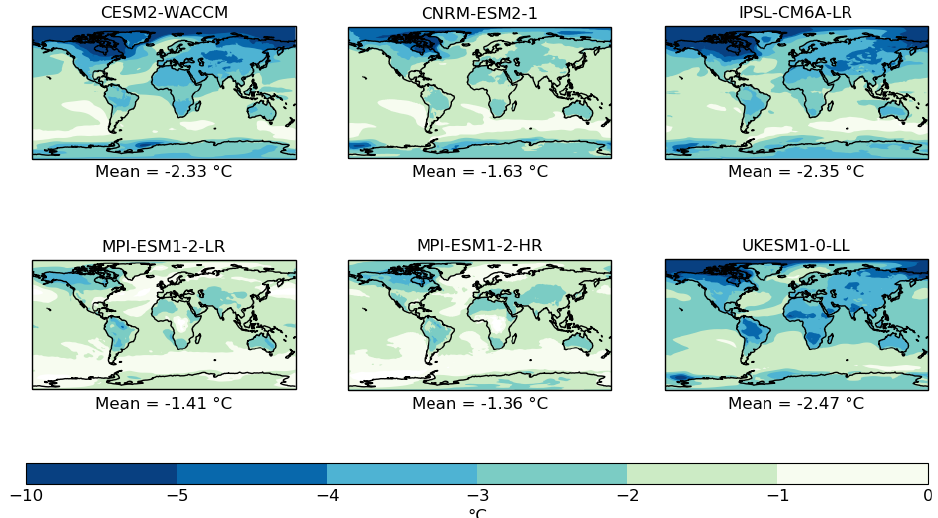
Figure 1. G6sulfur minus ssp585 difference in 2081–2100 annual mean near-surface air temperature ( ◦ C) for each model; all results are ensemble